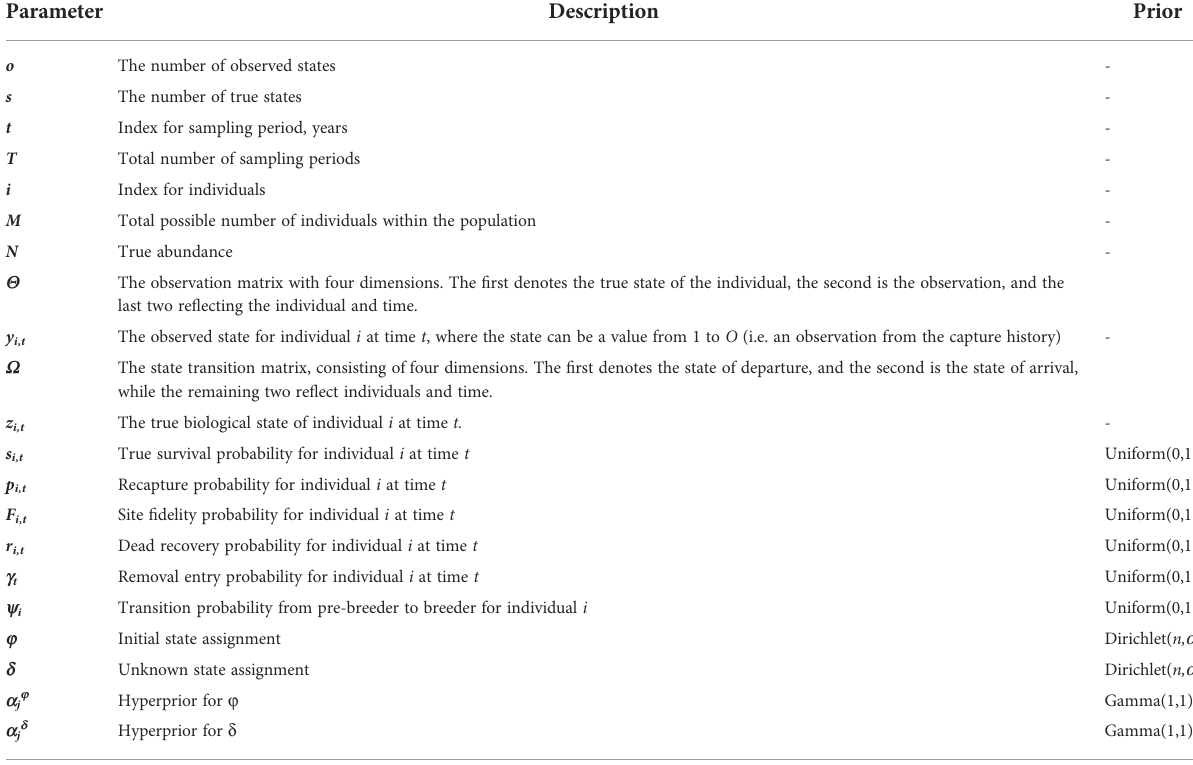
TABLE 1 List of notations and focal parameters estimated, brief description and priors used within the mark-recapture-recovery model.